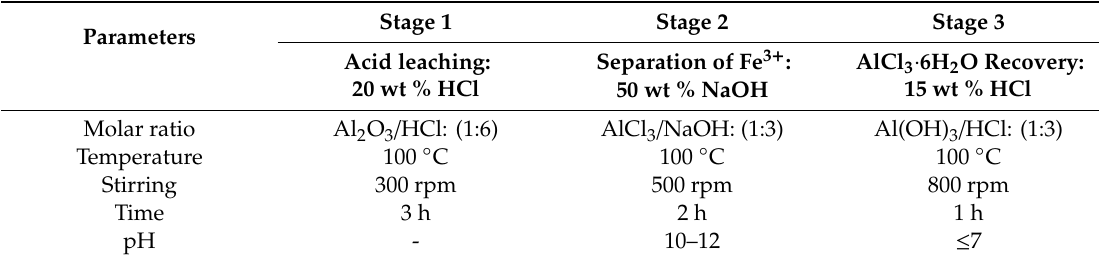
Table 1. Parameters for aluminum chloride